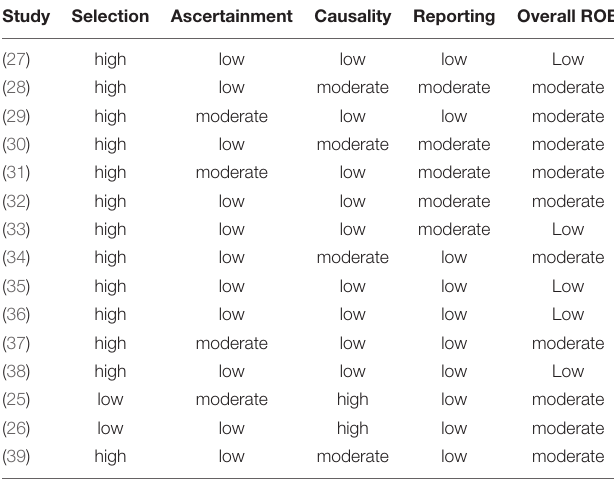
TABLE 1 | Risk of bias assessment of included